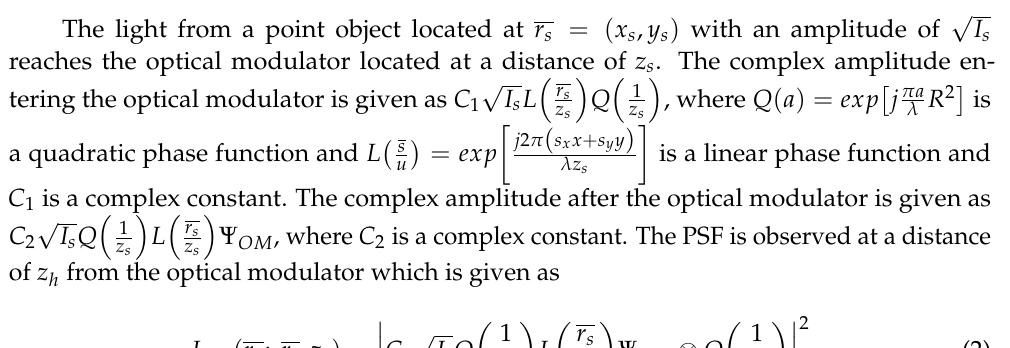
For an axicon, i.e., Ψ OM = exp